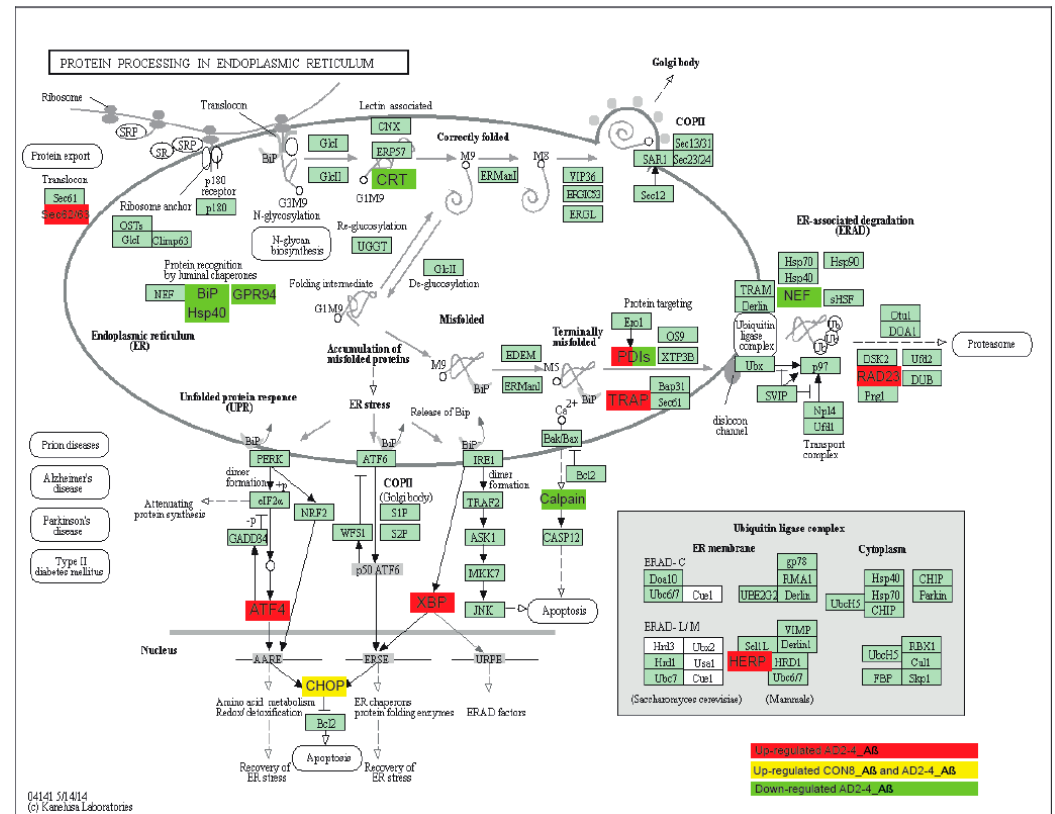
Figure 8. Representation of the KEGG protein process in endoplasmic reticulum pathway. Upregulated DEGs genes in response to A β -S8C stimulation in AD2-4 neuronal cultures are shown as red boxes, upregulated DEGs genes in response to A β -S8C stimulation in CON 8 and AD2-4 neuronal cultures are shown in yellow boxes and downregulated DEGs in AD2-4 neuronal cultures are shown as green boxes.